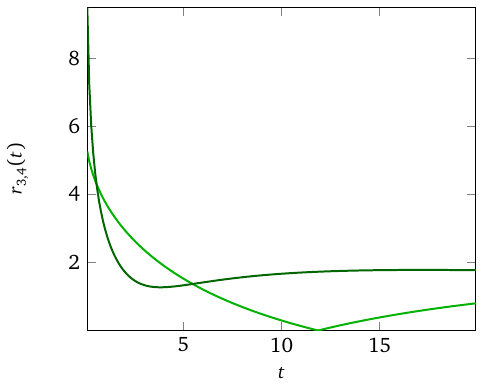
Figure 2: r (resp. r ) as a function of t , in light (resp. dark) green. These ratios 3 4 give an estimate of the smallest value of γ for which the series is